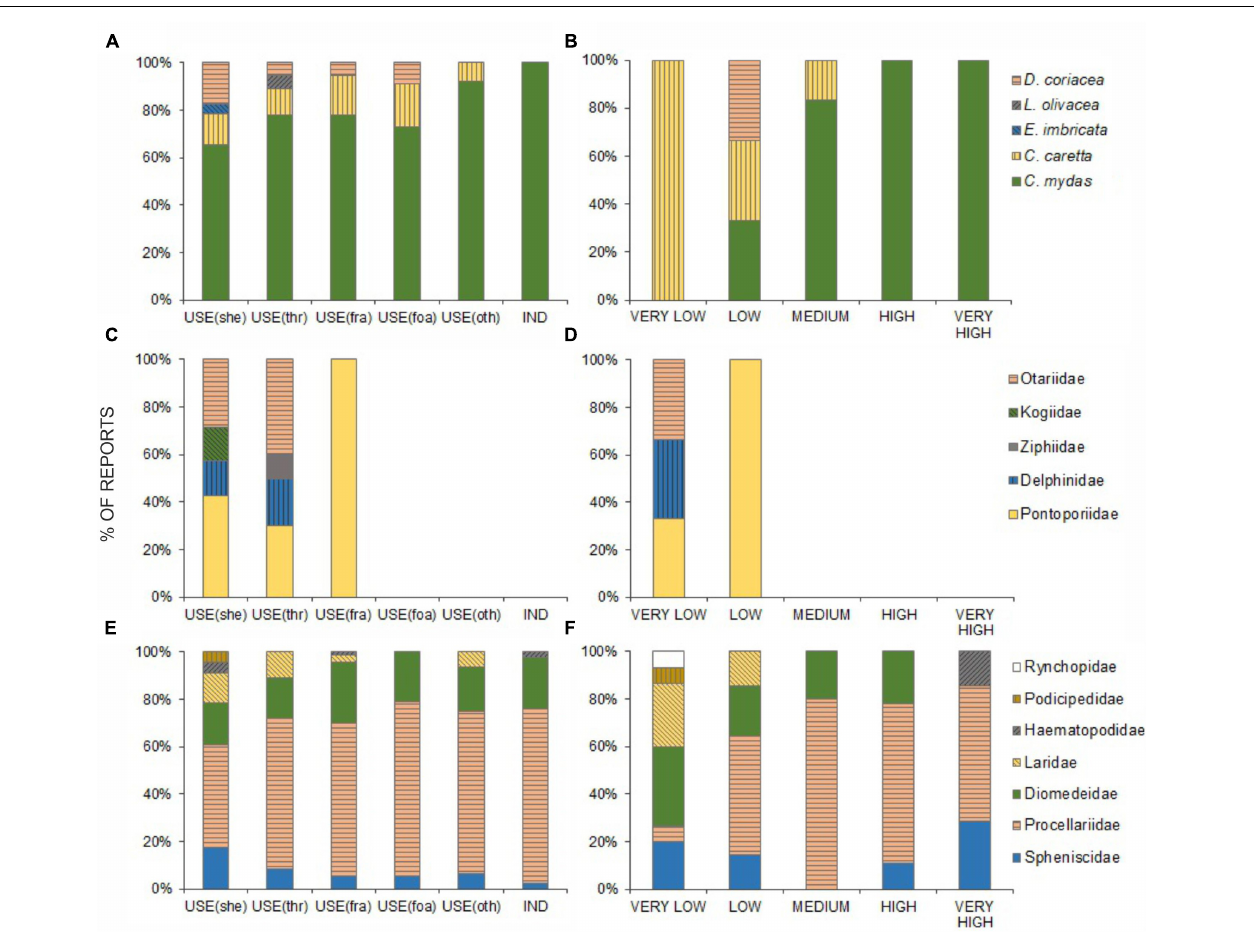
FIGURE 3 | Type and rate of incidence of plastic ingestion by species of marine turtles (A,B) , and family of marine mammals (C,D) and seabirds (E,F) in the Warm Temperate Southwest Atlantic. IND, industrial plastic pellets; USE, user plastics (subcategories: she, sheetlike plastics; thr, threadlike plastics; foa, foamed plastics; fra, fragments; and oth, other); URB, plastics from urban centers; FISH, plastics from fishing